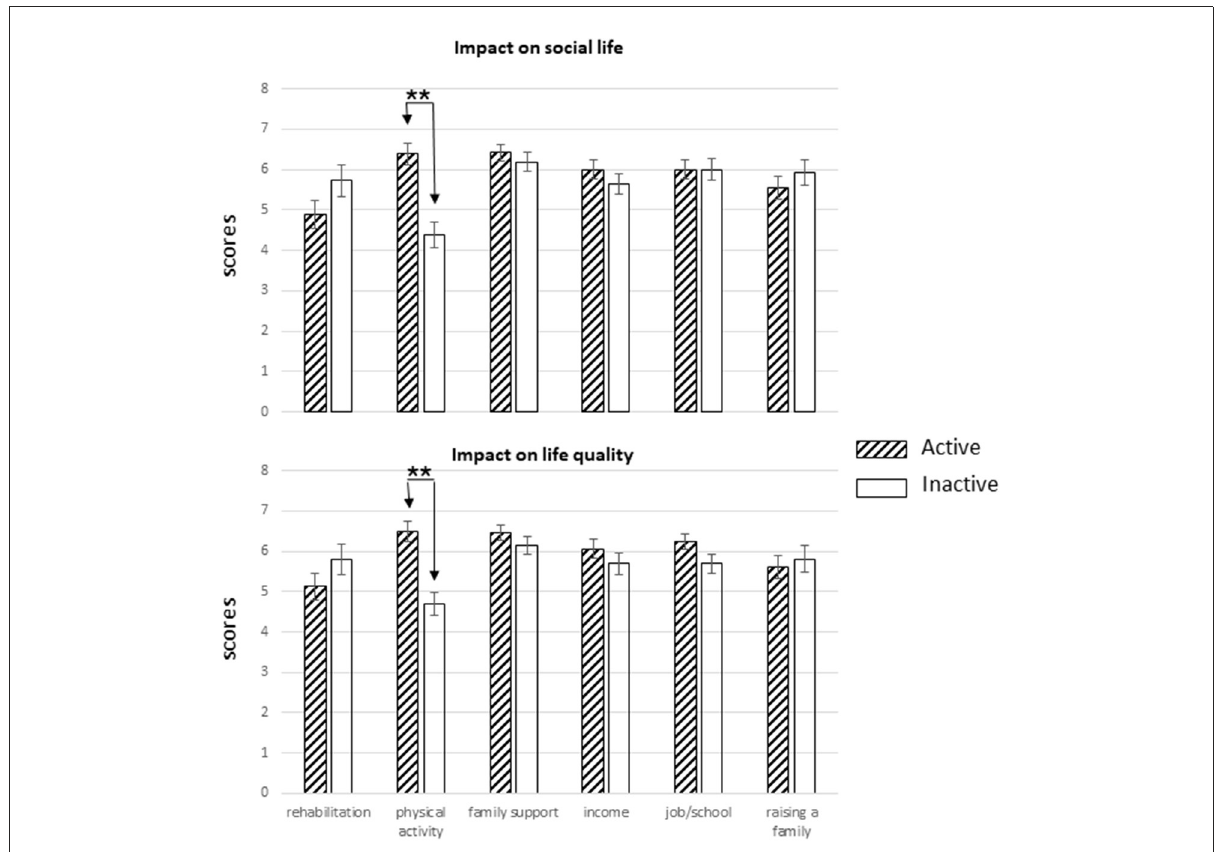
FIGURE1 Impact of rehabilitation, physical activity, family support, income, job/school, and raising a family on social life (upper panel) and life quality (lower panel) of active and inactive groups. For each group, the mean score ( ± SEM) of each variable is shown. Significant differences (** p < 0.01) between the groups are